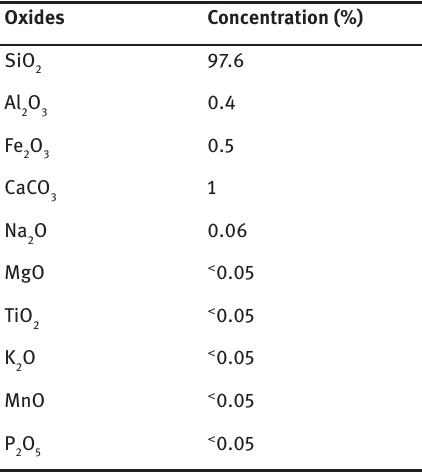
Figure 4: Scanning electron Micrograph of Biskra Dune Sand (lower magnitude). Table 2: X-ray fluorescence of the Biskra Silica Dune Sand.